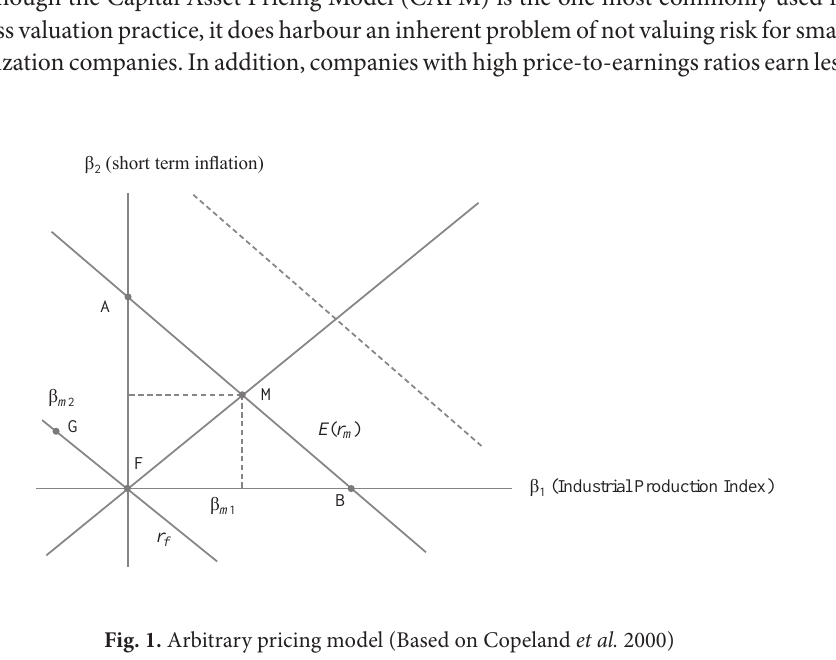
Fig. 1. Arbitrary pricing model (Based on Copeland et al.